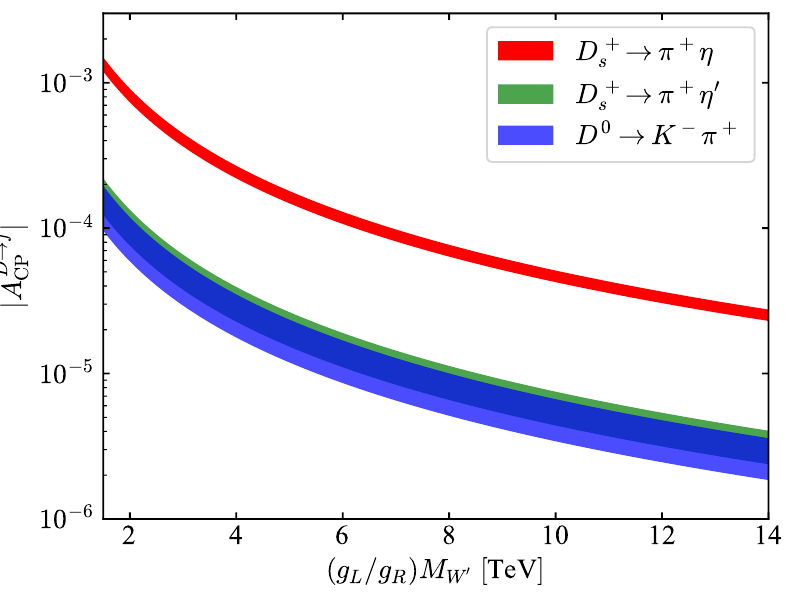
Figure 1 . Absolute value of the maximal CP asymmetry of the partial width of Cabibbo-favored charmed meson decays in the SU(2) L (cid:2) SU(2) R (cid:2) U(1) B (cid:0) L model (without charge symmetry). The bands represent the combination of theoretical uncertainty evaluated by varying the matching scales as M W = 2 (cid:20) (cid:22) W (cid:20) 2 M W and M W 0 = 2 (cid:20) (cid:22) W 0 (cid:20) 2 M W 0 , and uncertainty from the 1 (cid:27) errors of the diagrammatic